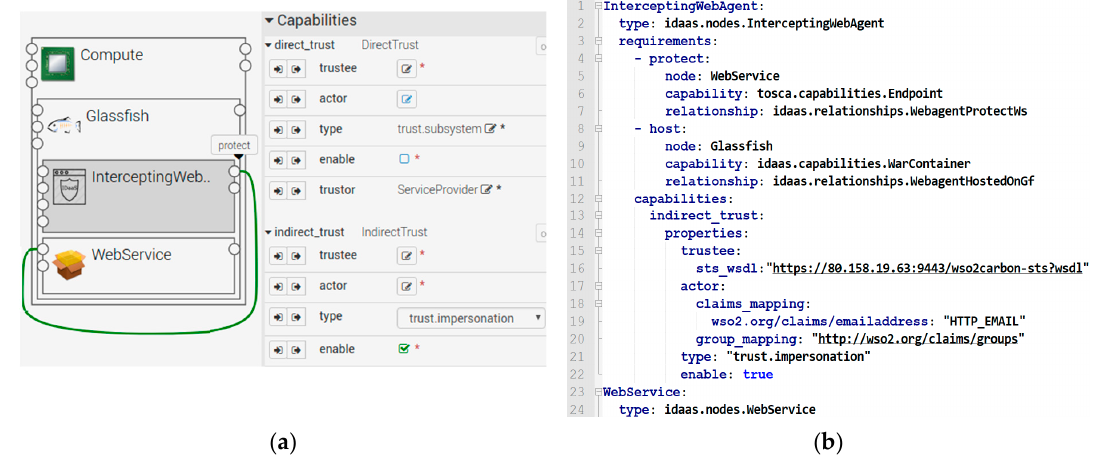
Figure 9. The topology editor ( a ) and topology description ( b ) for the delivery service.